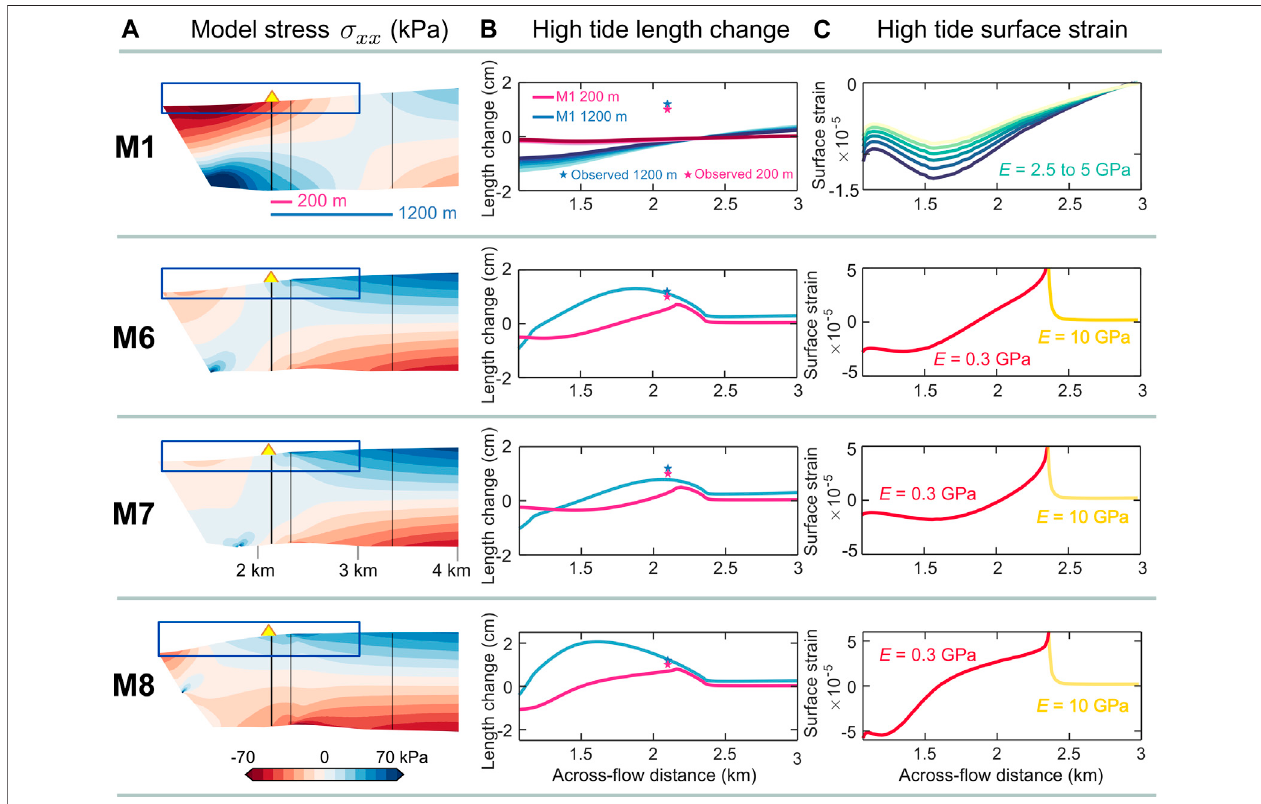
FIGURE 12 | Column (A) inset boxes show the section of the ice surface plotted in (B) and (C) . Column (B) shows the surface extension/compression associated with an upward de fl ection over 200 and 1,200 m transects. At the location of the fi eld camp, the observed length change (surface extension) is +1.0 and +1.2 cm (indicated by the stars). The modelled length change is computed for 200 and 1,200 m segments, moving along the ice surface at 10 m increments. Column (C) shows the pattern of across- fl ow surface strain, computed for each model element along the ice surface. In (C) , the transition from compression (negative) to extension (positive) corresponds tothe location ofthe positive/negative transition inthe contourmaps incolumn (A) . In (B) the location ofthe transition also depends on the length scale of the strain measurement.